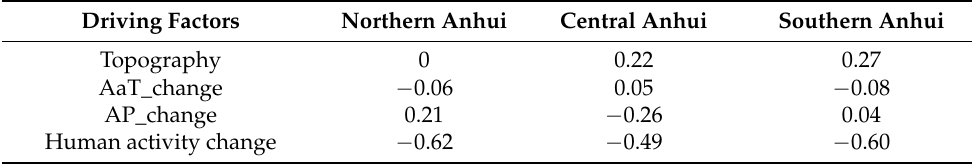
Table 6. The total impact of drivers on EVI variation in each district of Anhui Province. Driving